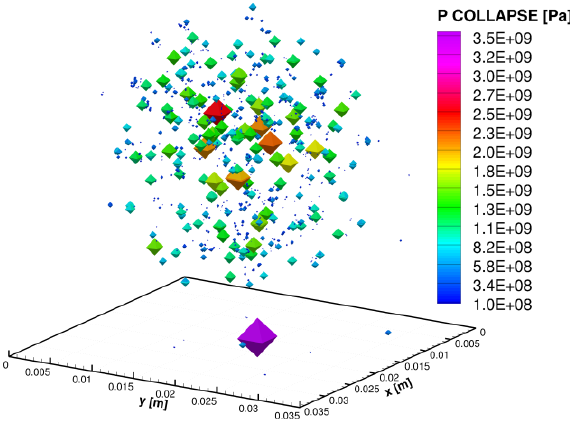
Fig. 6: Setup I, d = 3.2 mm. Collapse detector: collapses below1000 bar are not shown, size and color of diamonds represent collapse locations and predicted pressure